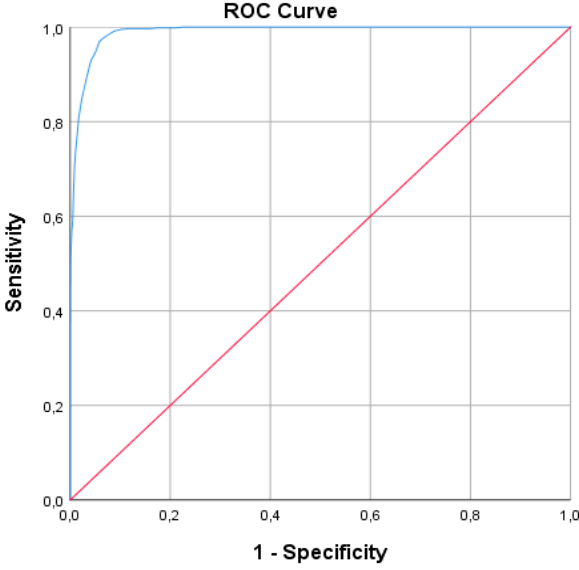
Figure 2. The receiver operating characteristic (ROC) curve of the Spanish version of GPIUS2.